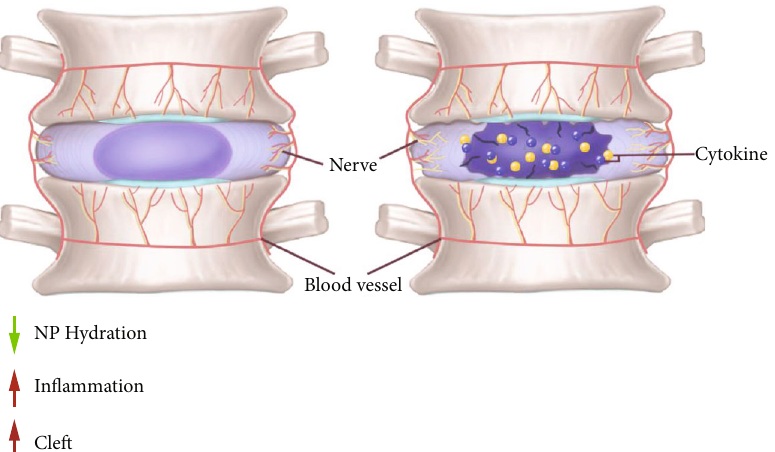
Figure 1: The morphological alteration in degenerative IVD. The schematic diagram shows healthy IVD and degenerative IVD in left and right, respectively. As the degeneration of the IVD, there is hydration loss and appearance of clefts in the bulged NP and fi brotic AF. The in fl ammation in the IVD intensi fi es with the increase of sorts of cytokines. Inward innervation which is associated with the pain in IDD is